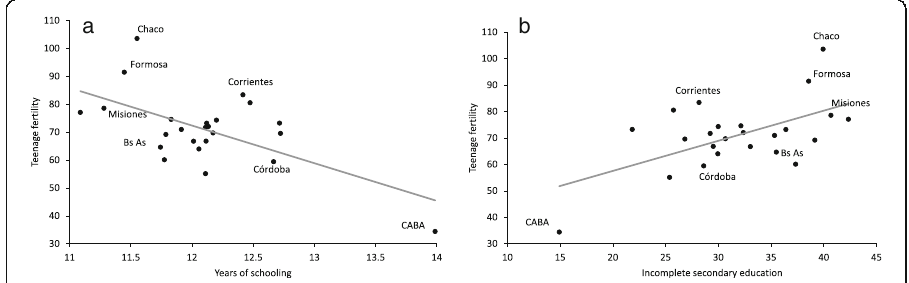
Fig. 3 Teenage fertility rate (number of live births per 1000 women aged 15 – 19) and education (women aged 25 – 40), by province. Argentina, 2011. a Years of schooling (mean). b Incomplete secondary education